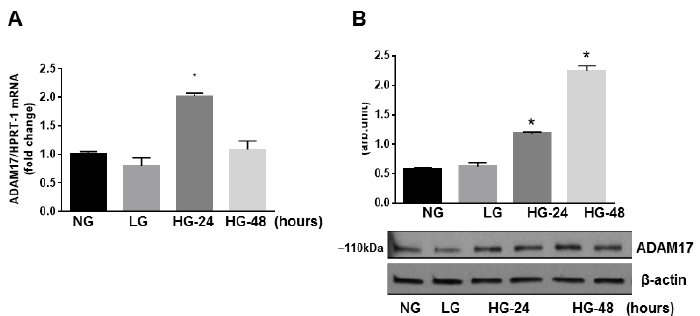
Figure 6. Effect of high glucose on ADAM17 expression in vitro. ( A ) QPCR analysis of ADAM17 mRNA. ( B ) Representative blots and densitometry analysis of ADAM17 protein expression in HREC treated with 5 mM D-glucose (NG, normal glucose) or 25 mM D-glucose (HG, high glucose) for 24–48 h. L-glucose (LG, 25 mM) served as the osmotic control). * p < 0.001 NG vs. HG. Data presented as mean ± SE. n = 3.